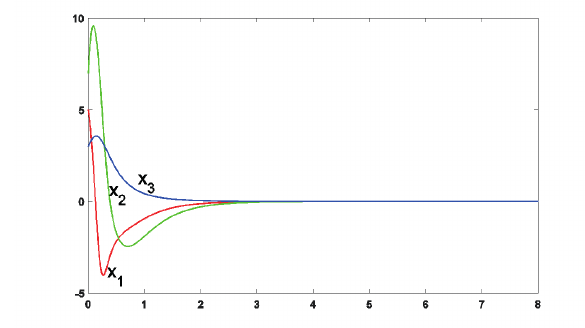
Fig. 1: Time response of the controlled Zhang chaotic system.